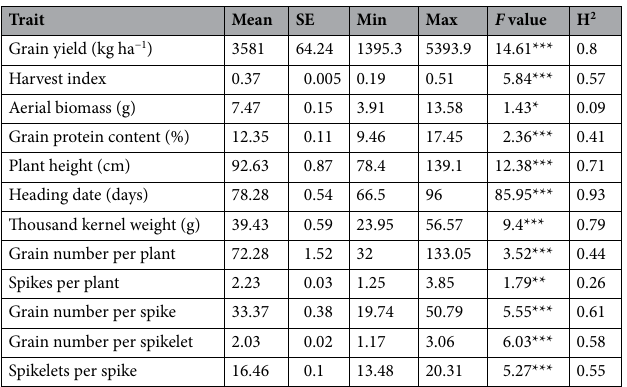
Table 3. Summary of mean, ranges, F value (for genotype effect) and the heritability for 12 agronomic traits assessed in a durum wheat collection in three environments in Argentina. SE standard error, H 2 broad sense